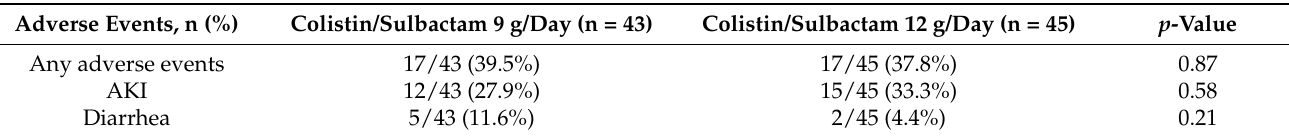
Table 4. Adverse